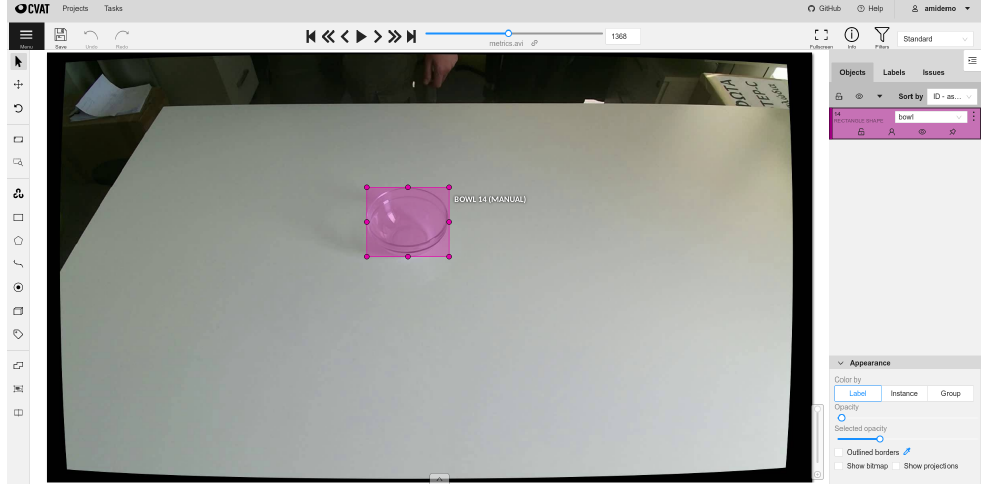
Figure 3. The annotation workspace screen of CVAT. In the particular case, the video frame contains an object corresponding to “bowl” class and a bounding box containing exactly the object that has already been